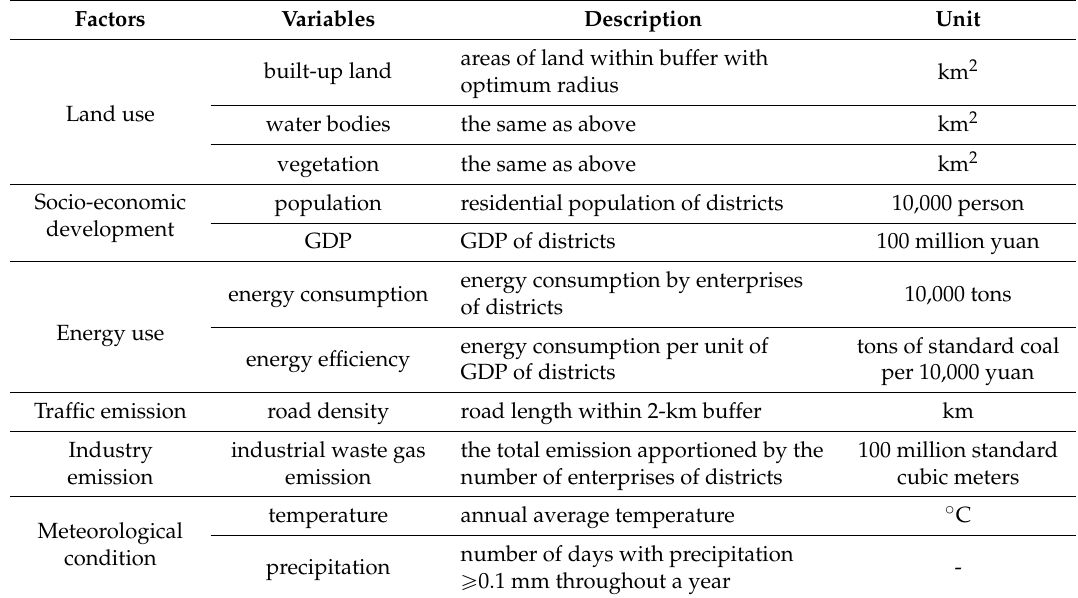
Table 1. Descriptions of all independent variables in quantitative